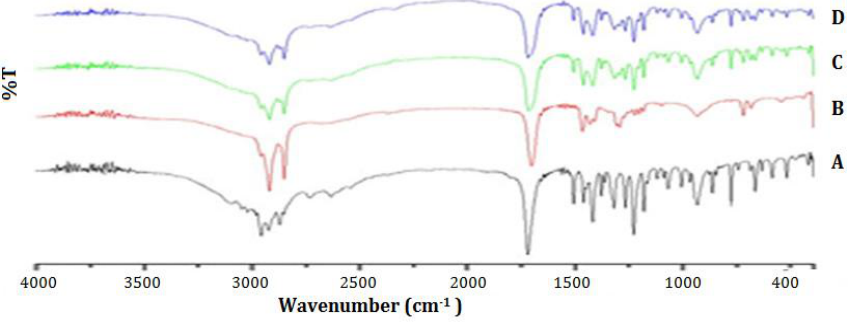
Figure 7. FT-IR spectra of A. Ibuprofen, B. Stearic acid, C. Binary mixture of 4:6 weight ratio, and D. Compressed binary mixture of 4:6 weight ratio at 19.9